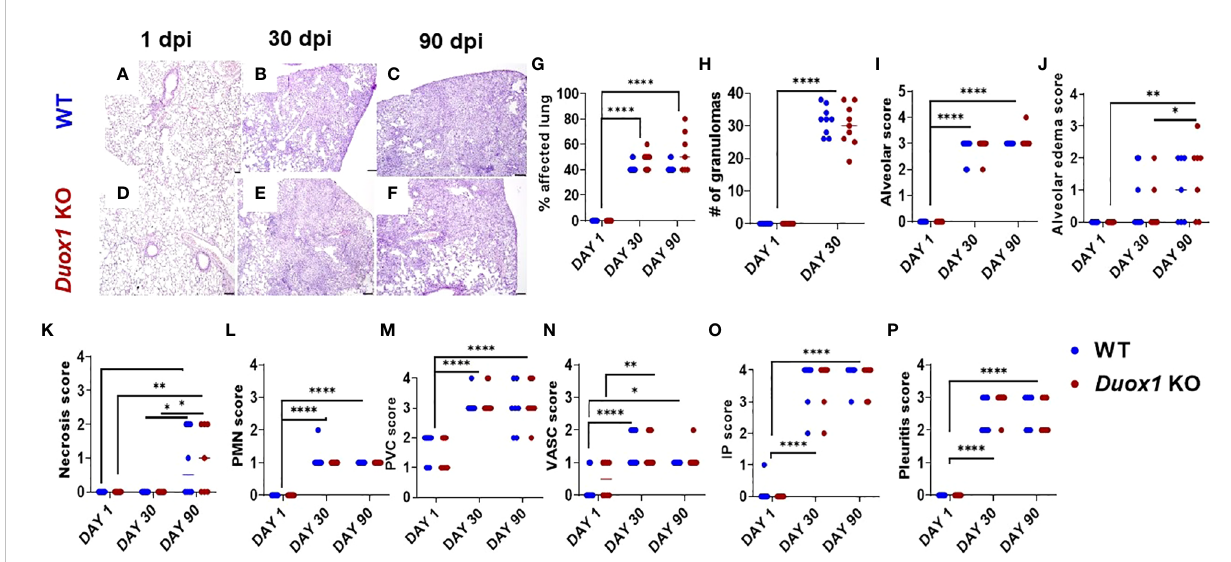
FIGURE 3 Lung pathology during Mtb infection is independent of Duox1. Mtb -infected lung lobes from both Duox1 KO and WT mice were isolated and fi xed in 10% buffered formalin at 1, 30, and 90 day(s) post-infection. Fixed lung tissues were processed for histology, sectioned, and subjected to hematoxylin and eosin staining. Lungs collected at 1 day post-infection from both mouse background (A, D) do not show any evidences of lung pathology while granuloma-like lesions in both groups are visible at 30 (B, E) and 90 (C, F) days post-infection. (G) Comparative percentage of lung tissue affected (0% to 80%). (H) The number of in fl ammatory aggregates inside the lung tissues (from 0 to 40 maximum). The lung histological score was assessed with a scale from 0 to 4 and included the (I) alveoli, (J) the alveolar edema, (K) necrosis, and (L) polymorphonuclear neutrophils as well as (M) perivascular score. (N) The vascular, (O) IP score and (P) pleuritis are also shown. Sample sizes: n=8 Duox1 KO; n=8 WT mice for histopathological scoring at 1 day post-infection. For 30 days post-infection: n=9 Duox1 KO and n=9 WT mice were used. For 90 days post- infection, n=6 WT and n= 7 Duox1 KO animals were assessed. ANOVA with multiple comparison was used for statistical data analysis. *p<0.05, **p<0.01, ****p<0.0001. IP, intraperitoneal, WT, wild-type; day post infection, days post-infection; PMN, polymorphonuclear neutrophil granulocyte; Duox1 KO, Duox1 -de fi cient; WT, wild-type.